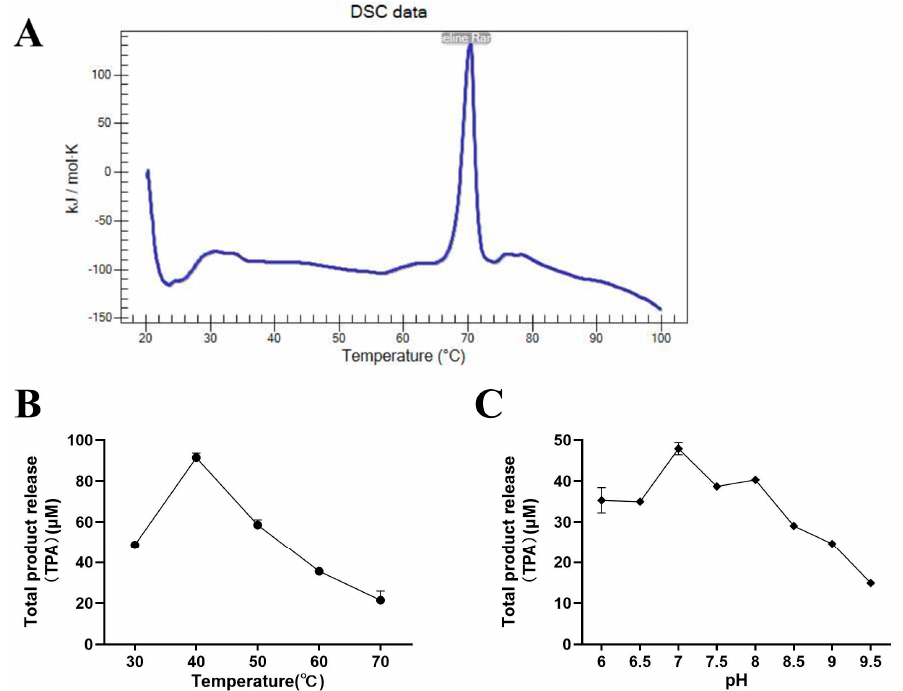
Figure 3. The Tm , optimal pH and temperature of Tcca. ( A ) The Tm of the Tcca; ( B ) The optimal temperature of Tcca; ( C ) The optimal pH of Tcca. The optimum temperature of Tcca was determined to be in the range of 30 to 70 °C, and the optimum pH of Tcca was tested in buffers at pH values ranging from 6.0 to 9.5. All the hydrolysis reactions were performed using a piece of PBAT film (Ø8 mm) with 10.9 µM enzyme in 0.8 mL buffer at 300 rpm for 24 h. Error bars denote the standard deviations calculated based on triplicated determinations.